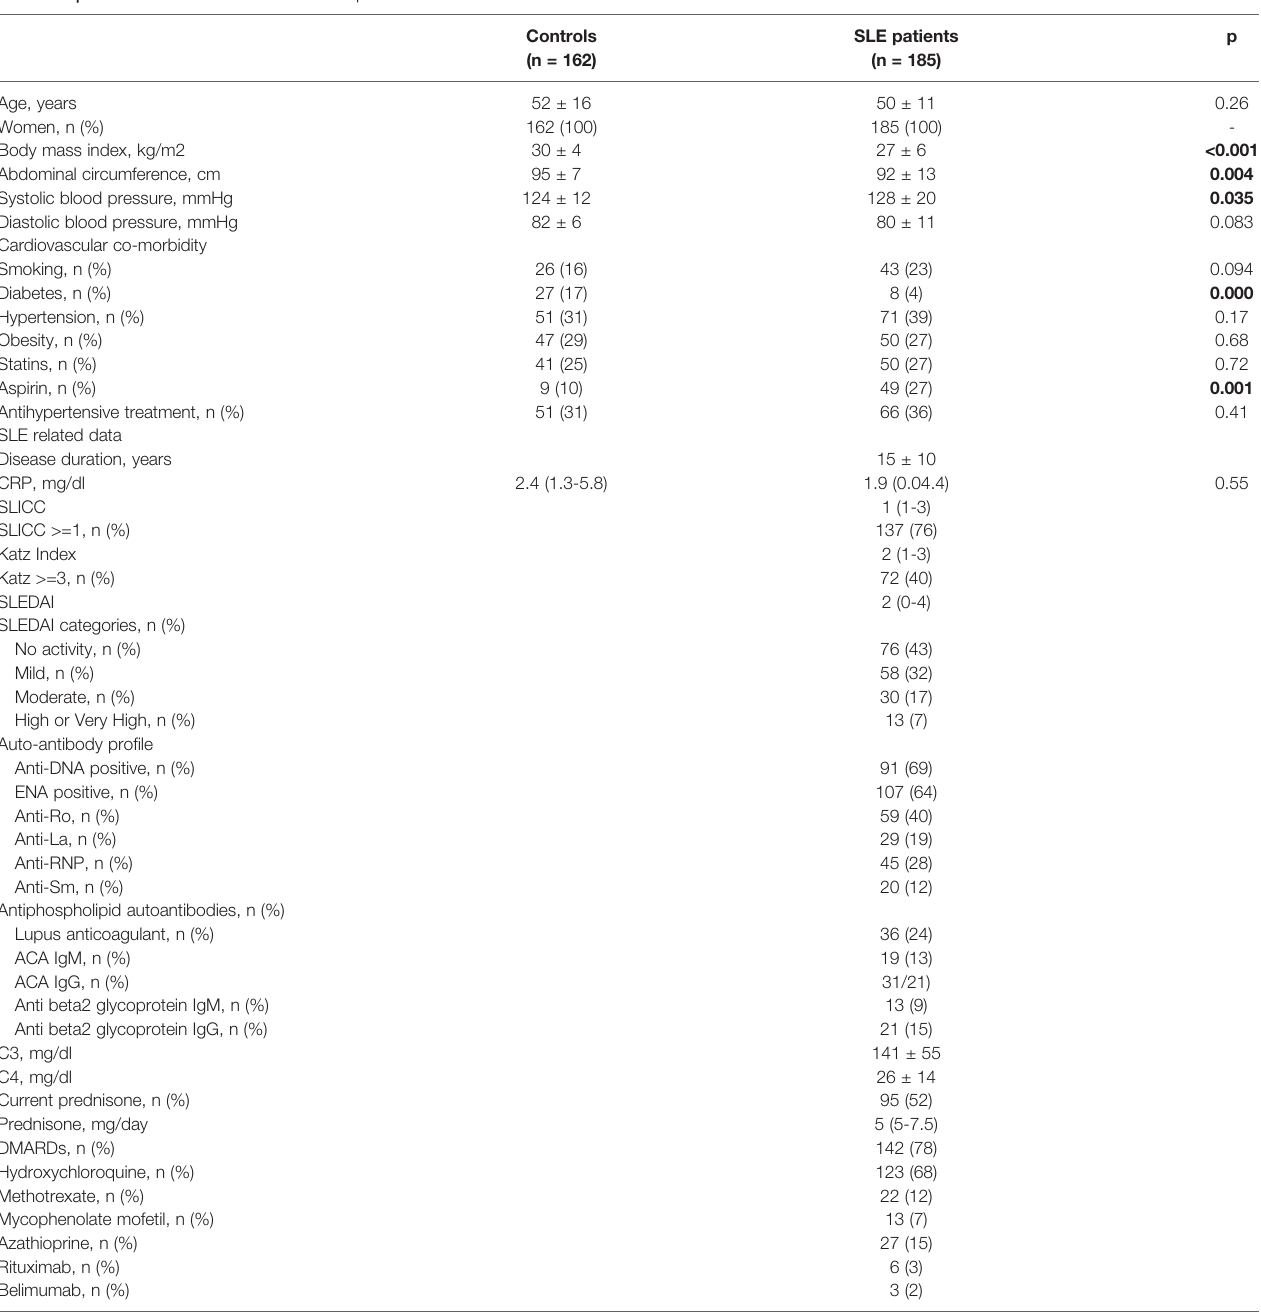
TABLE 1 | Characteristics of controls and SLE patients.